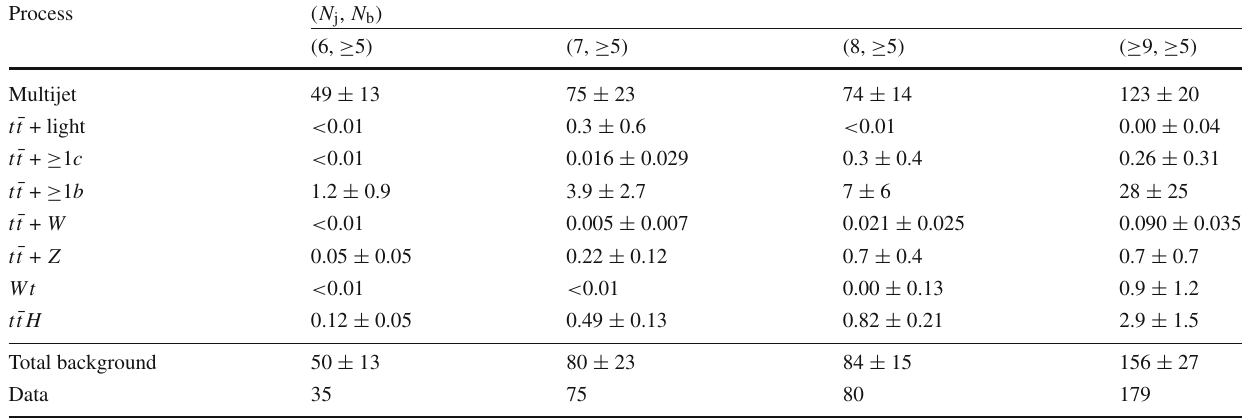
Table 4 Event yields from background predictions and data in the regions with N j = 6, 7, 8 or ≥ 9 and N b ≥ 5. The quoted uncertainties are the sum in quadrature of the statistical and systematic uncertainties